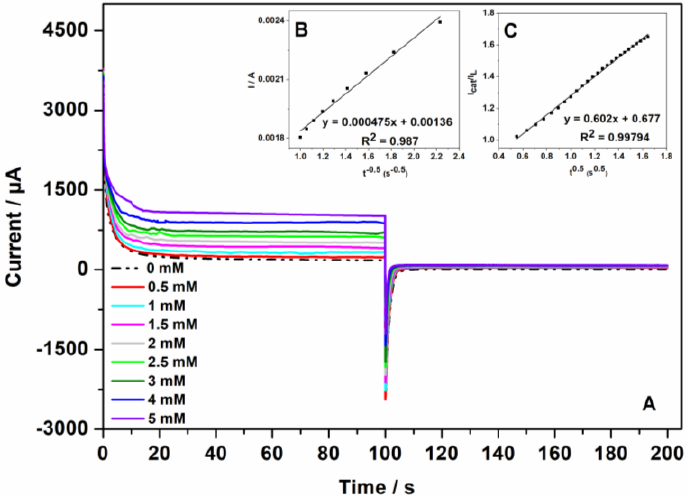
Figure 9. ( A ) Double-step chronoamperograms of Au-CuNC electrode in 50 mM NaOH for different glucose concentrations: 0, 0.5, 1.0, 1.5, 2.0, 2.5, 3.0, 4.0, and 5.0 mM (step potentials: +0.7 V and +0.25 V vs. Ag/AgCl); ( B ) dependency of I on t − 1/2 ; and ( C ) dependency of I cat /I L on t 1/2 .